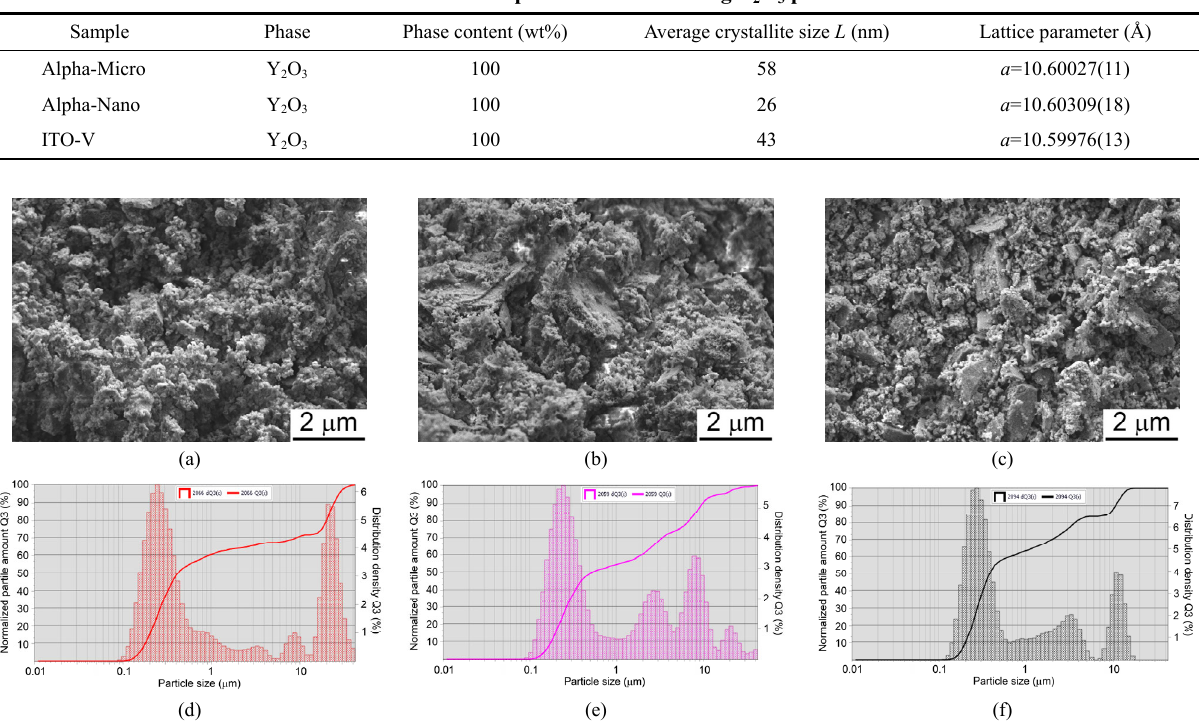
Fig. 3 SEM (a–c) and particle size distribution (d–f) of 0.86Y 2 O 3 ·0.09La 2 O 3 ·0.05Yb 2 O 3 powder mixtures prepared using Alpha-Micro (a, d), Alpha-Nano (b, e), and ITO-V (c, f) Y 2 O 3